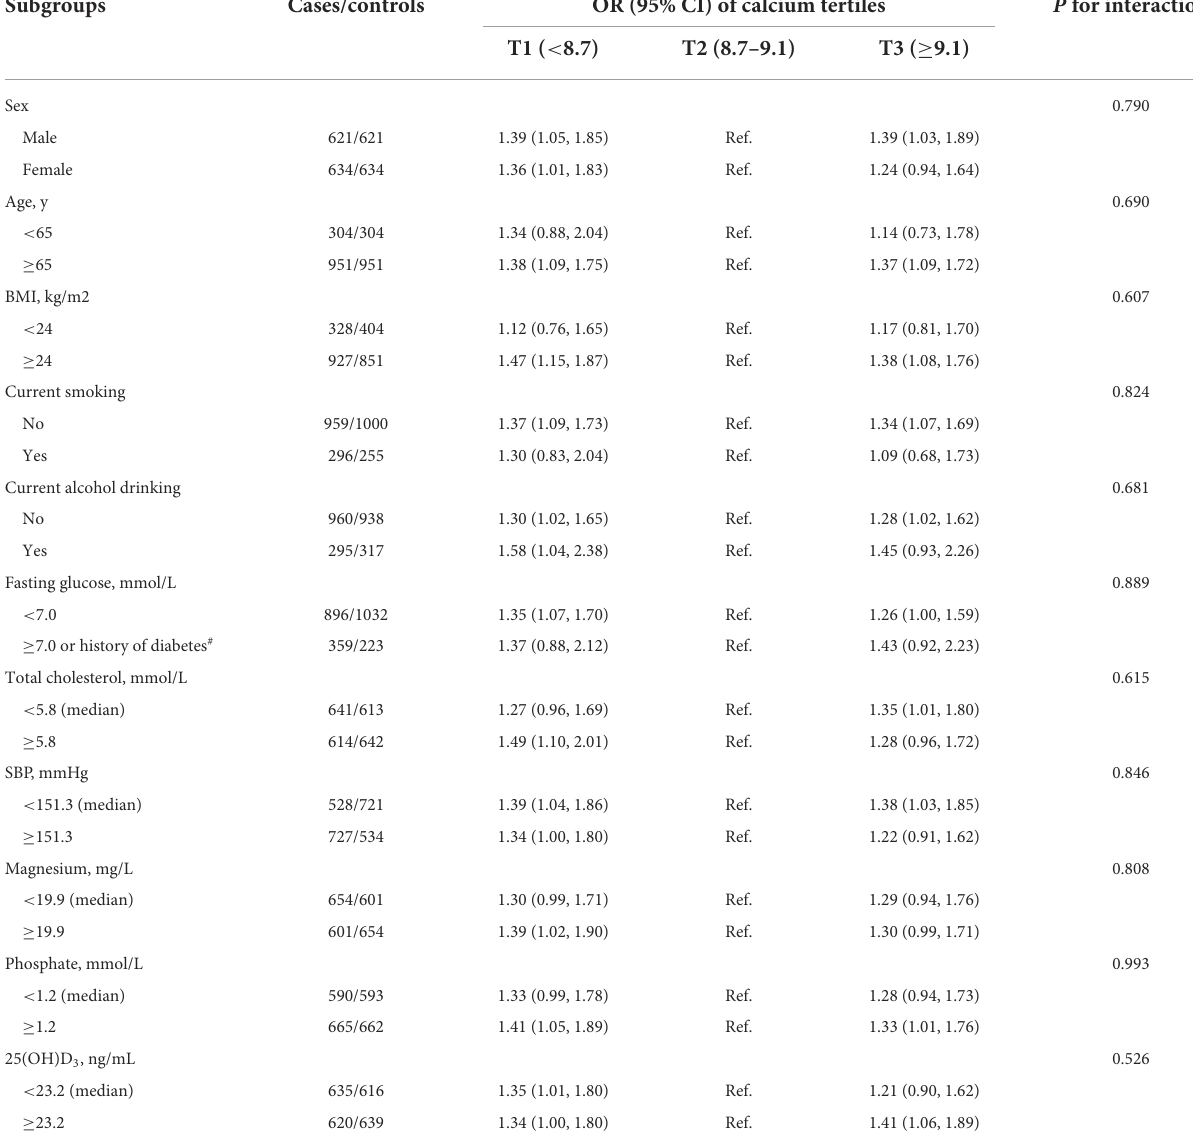
TABLE 3 The associations between serum albumin-corrected calcium and the risk of first stroke in various subgroups * .